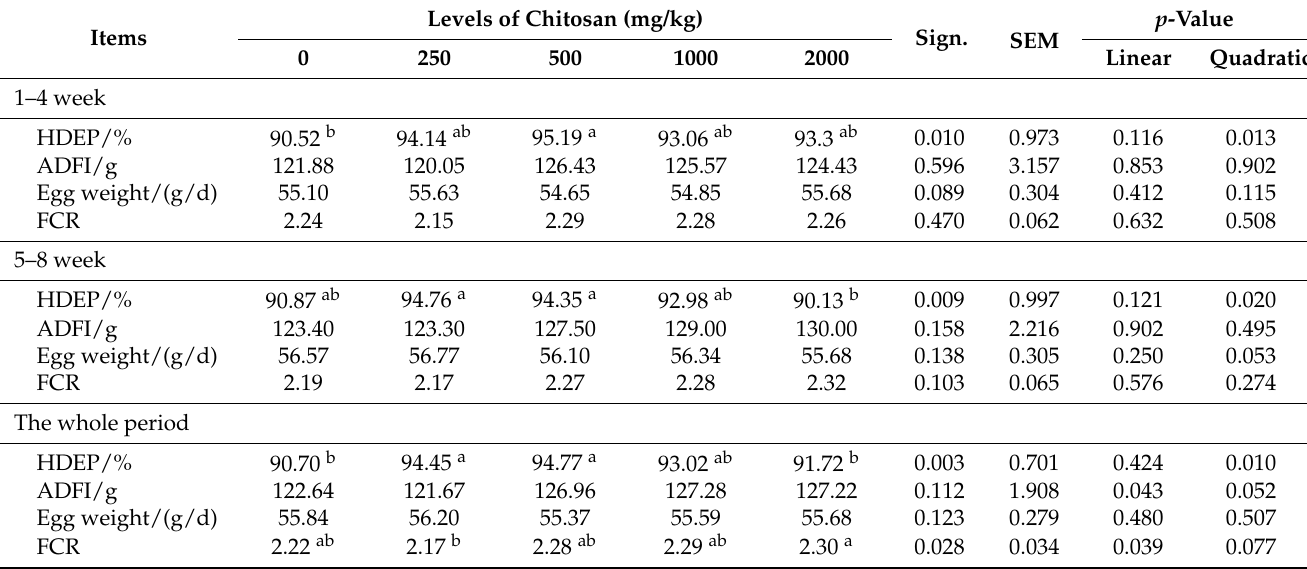
Table 3. Effects of dietary chitosan on the laying performance in laying breeders.